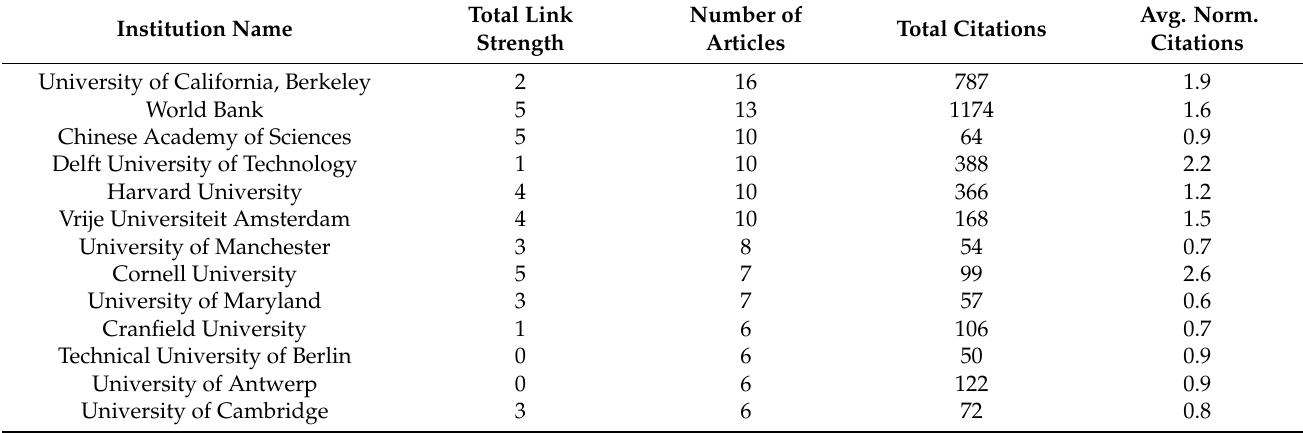
Table 3. Quantitative summary of institution impacts in infrastructure externalities